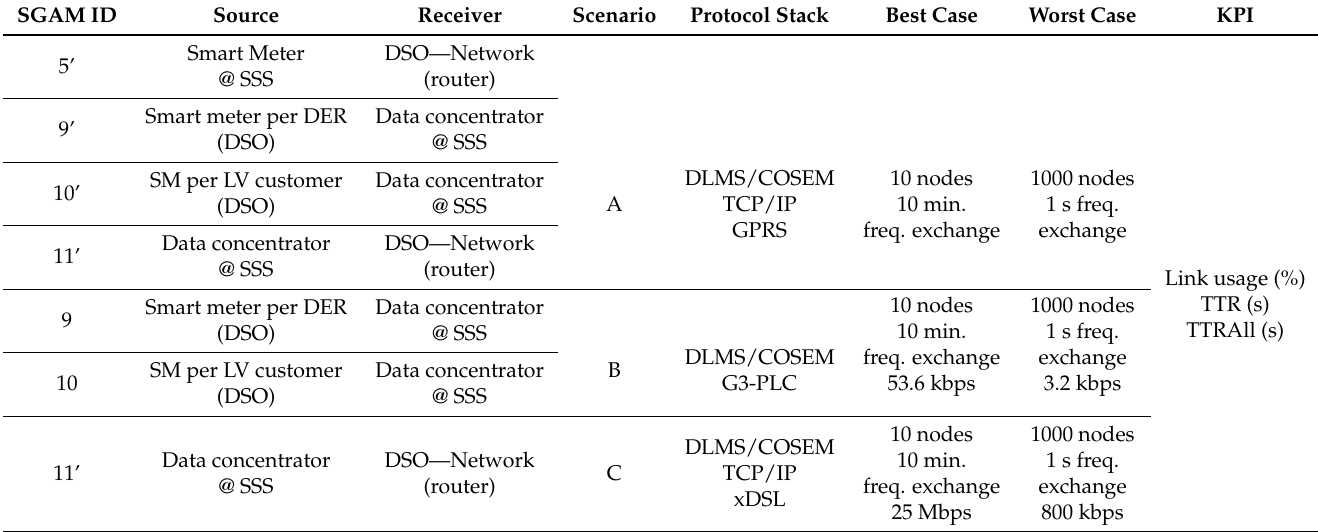
Table 8. Summary of the characteristics of the scenarios simulated as part of the quantitative